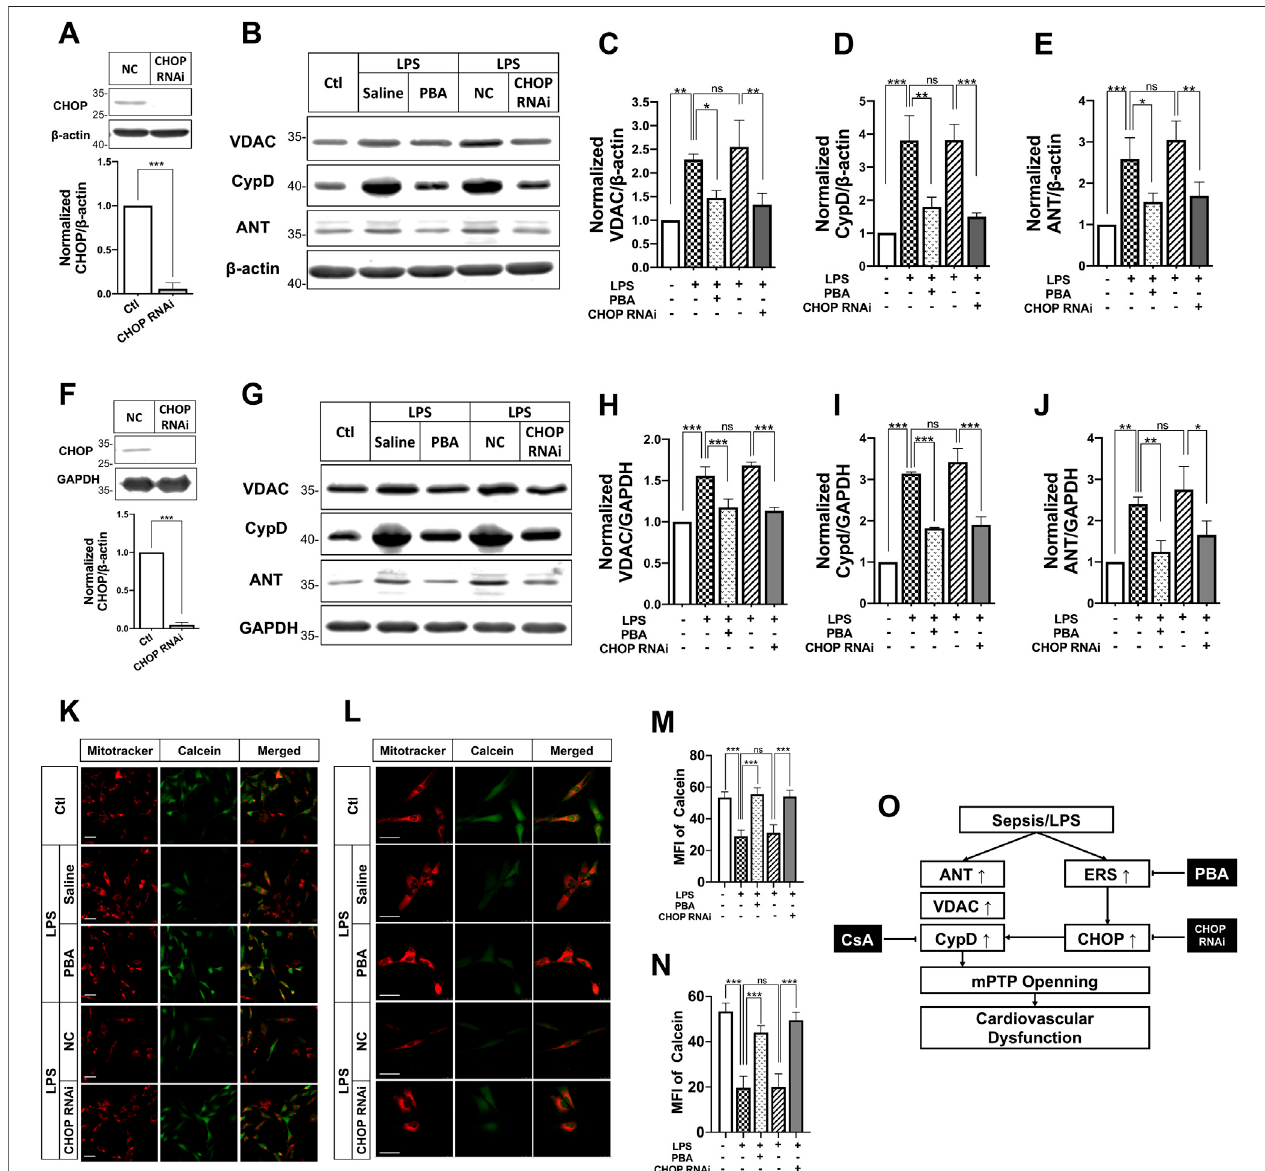
FIGURE 6 | Effects of ERS on mPTP opening and its related protein expression after septic shock in rats in LPS-treated VSMCs and H9C2 cardiomyocytes. (A) , effectsofCHOPRNAionCHOPexpressioninVSMCs; (B-E) ,effectsofanti-ERSwithPBAandCHOP-RNAiontheexpressionofmPTP-relatedproteinsANT,VDACsand CypDinVSMCs( n (cid:1) 3);f,effectsofCHOPRNAionCHOPexpressioninH9C2cardiomyocytes; (G-J) ,effectsofanti-ERSwithPBAandCHOP-RNAiontheexpressionof mPTP-related proteins ANT, VDACs and CypD H9C2 cardiomyocytes ( n (cid:1) 3); (K,M) , effects of anti-ERS with PBA and CHOP-RNAi on mPTP opening in LPS- challenged VSMCs ( n (cid:1) 21/group from 3 independent experiment); (L,N) , effects of anti-ERS with PBA and CHOP-RNAi on mPTP opening in LPS-challenged H9C2 cardiomyocytes ( n (cid:1) 21/group from 3 independent experiment); (O) , schematic ofsynergetic effect ofPBAand CsAprotecting vascular functionand bene fi ting to sepsis. Scale bar (cid:1) 50 μ m. CsA, cyclosporine A; PBA, 4-phenylbutyrate acid; MFI, mean fl uorescence intensity. * p < 0.05, ** p < 0.01, *** p < 0.001; ns , not signi fi cant.